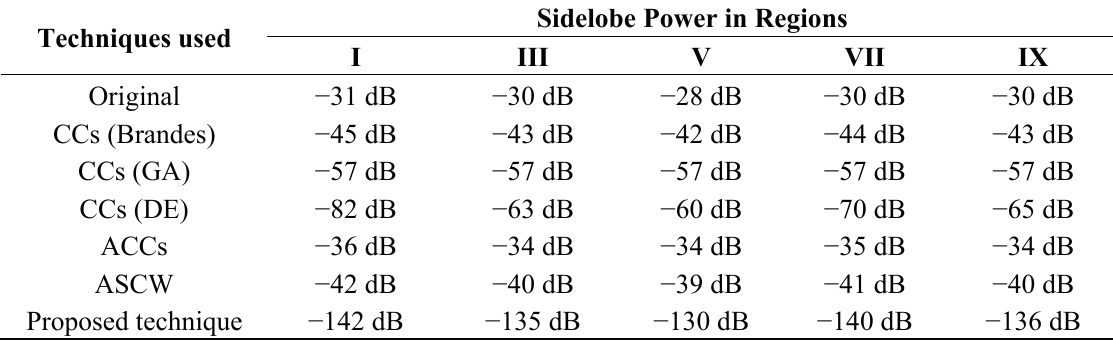
Table 3. Comparison of sidelobe suppression between existing and proposed techniques. Techniques